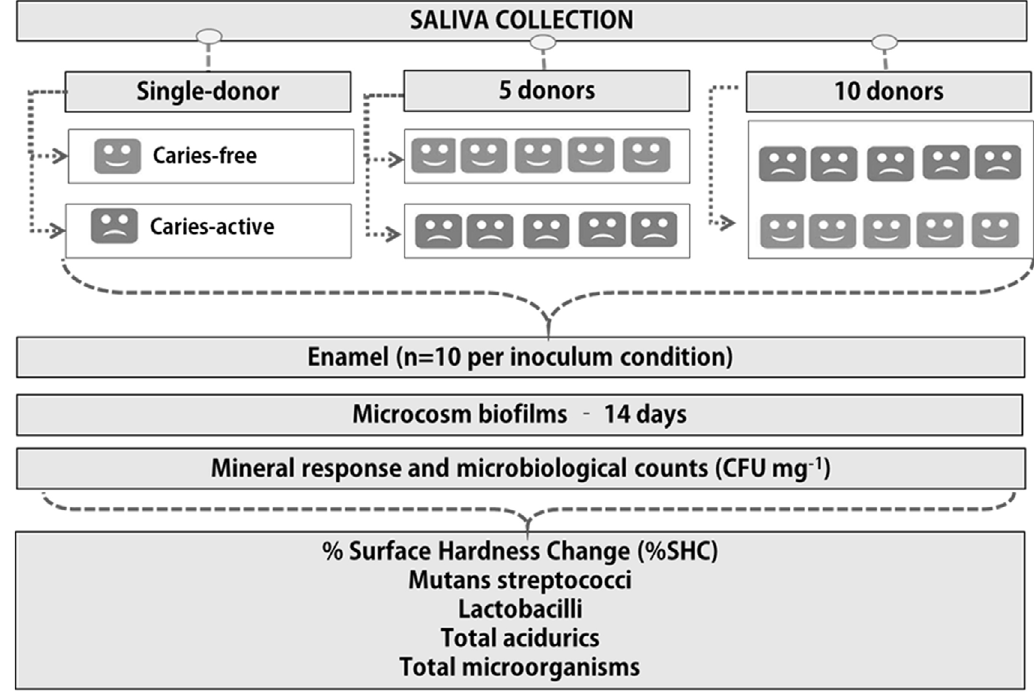
Figure 1- Study experimental design. Biofilms were formed over enamel specimens according to different inoculum conditions groups: single-donor (caries-free or caries-active), five donors (caries-free or caries-active) and 10 donors (five caries-free and five caries-active